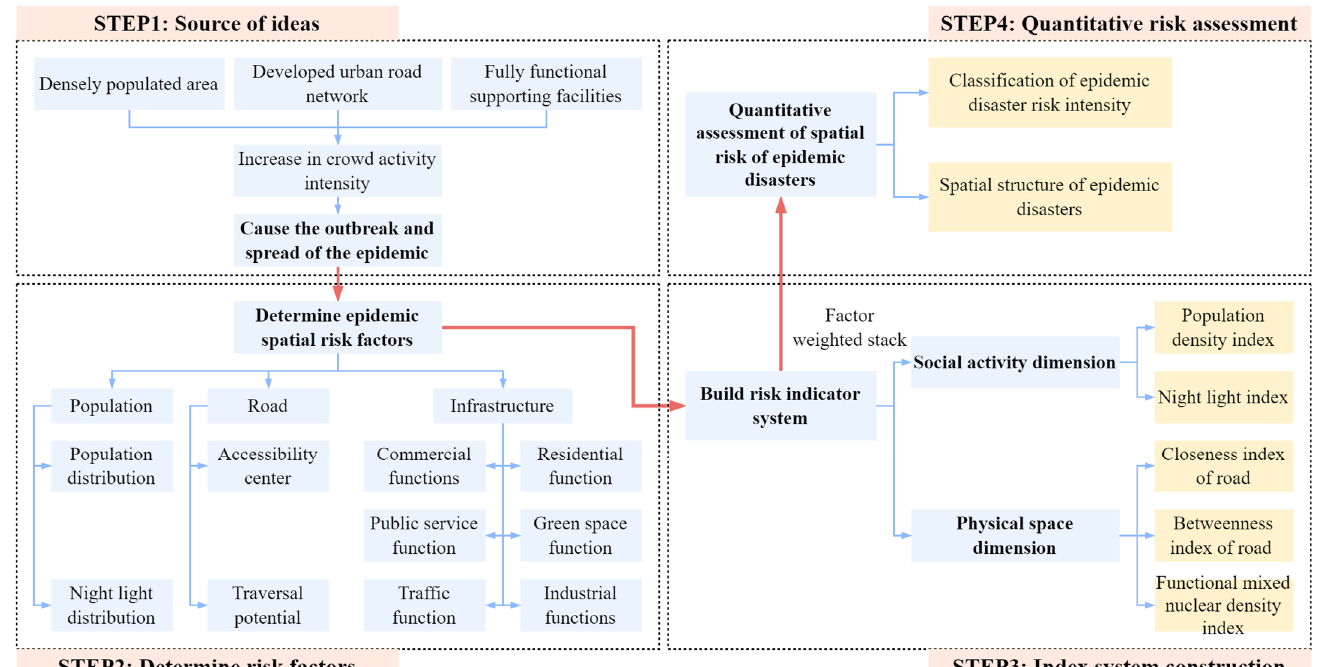
Figure 3. Research objectives and concepts.